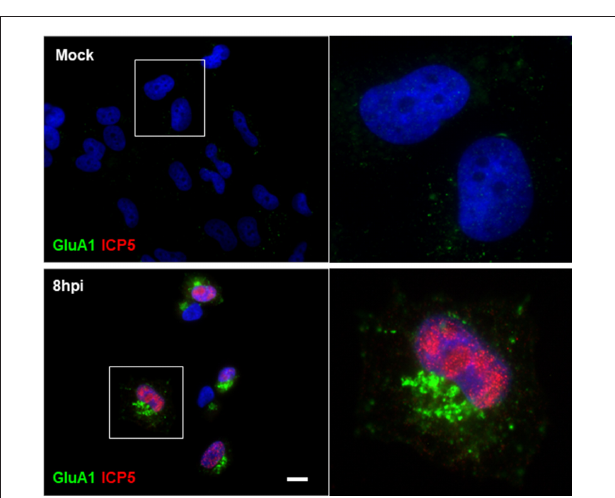
FIGURE 7 | Redistribution of the AMPA receptor (AMPAR) GluA1 subunit during HSV-1 infection in H4 cells. Untreated (mock) or HSV-1-infected (MOI = 10) H4 cells during 8 hpi were stained with antibodies to GluA1 subunit and to ICP5 followed by secondary antibodies coupled to Alexa Fluor 488 and 594 dyes, respectively. Nuclei were stained with DAPI. Bar corresponds to 10 µ m. Magnification 630 × . The boxes inserted show a zoom capture of the indicated areas. The results shown are representative of three independent